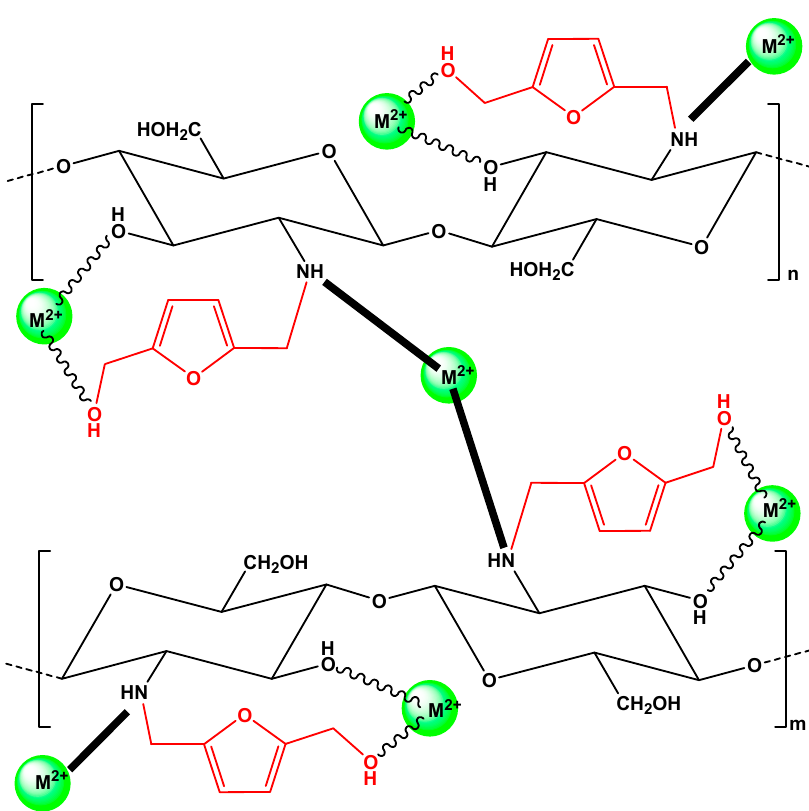
Figure 7. Proposed adsorption mechanism.